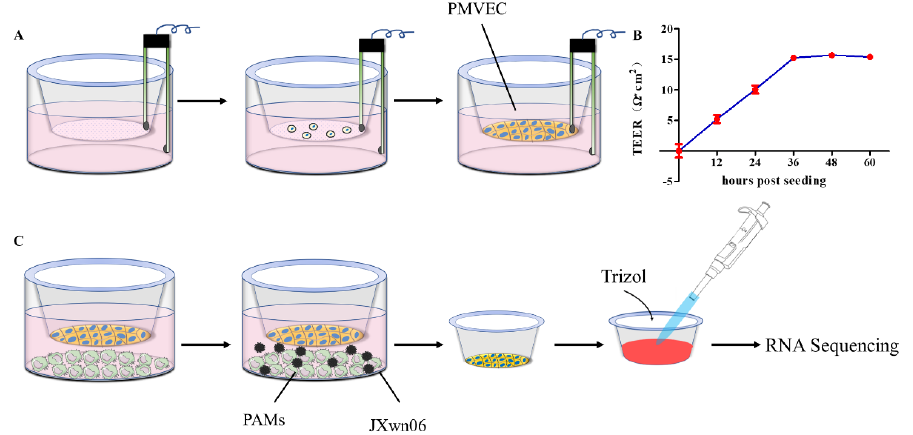
Figure 1. Schematic for PMVECs and primary PAMs transwell co ‐ cultures and the preparation of samples for RNA ‐ seq. ( A ) PMVECs were plated onto transwell semi ‐ permeable membranes (0.4 μ m pore size), and inserts with medium alone were used for blank resistance measurements. A TEER assay was used to evaluate the integrity of the PMVECs monolayer at indicated time points over 60 h. ( B ) Relative TEER values from three independent experiments performed in triplicate are plotted. The data are shown as means ± SD (standard deviation). ( C ) Upon the PMVEC monolayer grown to confluence, primary PAMs were infected with HP ‐ PRRSV JXwn06 at an MOI of 5 or treated with mock ‐ infected. Total RNA of PMVECs was extracted by using TRIzol reagent at different time points post viral infection for RNA ‐ seq analysis.